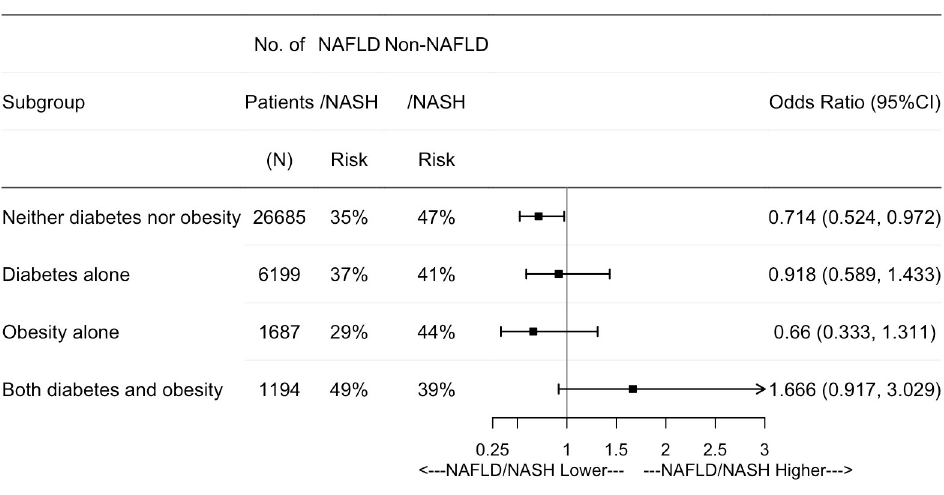
Fig 4. Adjusted odds ratio of TTR > 60% among NAFLD/NASH vs Non-NAFLD/NASH using the propensity score stratification approach after warfarin initiation. Note: NAFLD: Nonalcoholic Fatty Liver Disease; NASH: Nonalcoholic Steatohepatitis; TTR: Time to Therapeutic